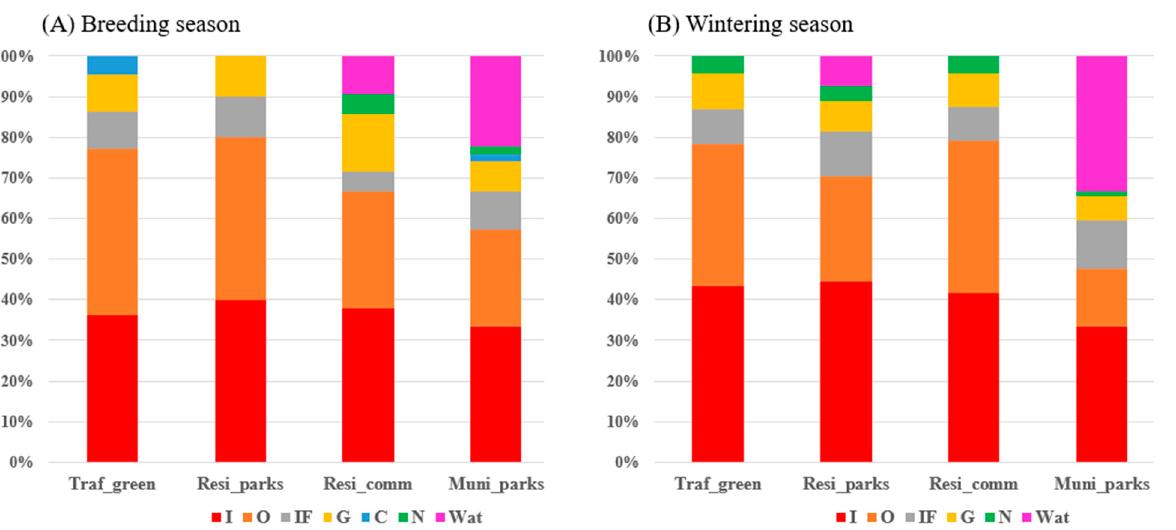
Figure 2. Cumulative histogram for the feeding type structure of avian communities in different habitat types during the breeding ( A ) and wintering ( B ) season. C—carnivores, I—insectivores, IF—insectivore–frugivores, G—granivores, O—omnivores, and N—nectarivores.